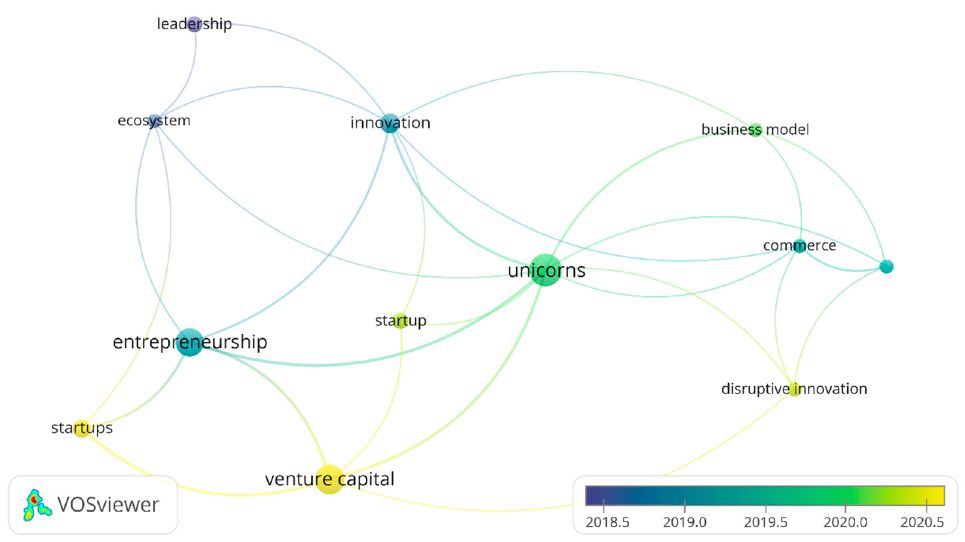
Figure 8. Overlay visualization (unicorns—SCOPUS).